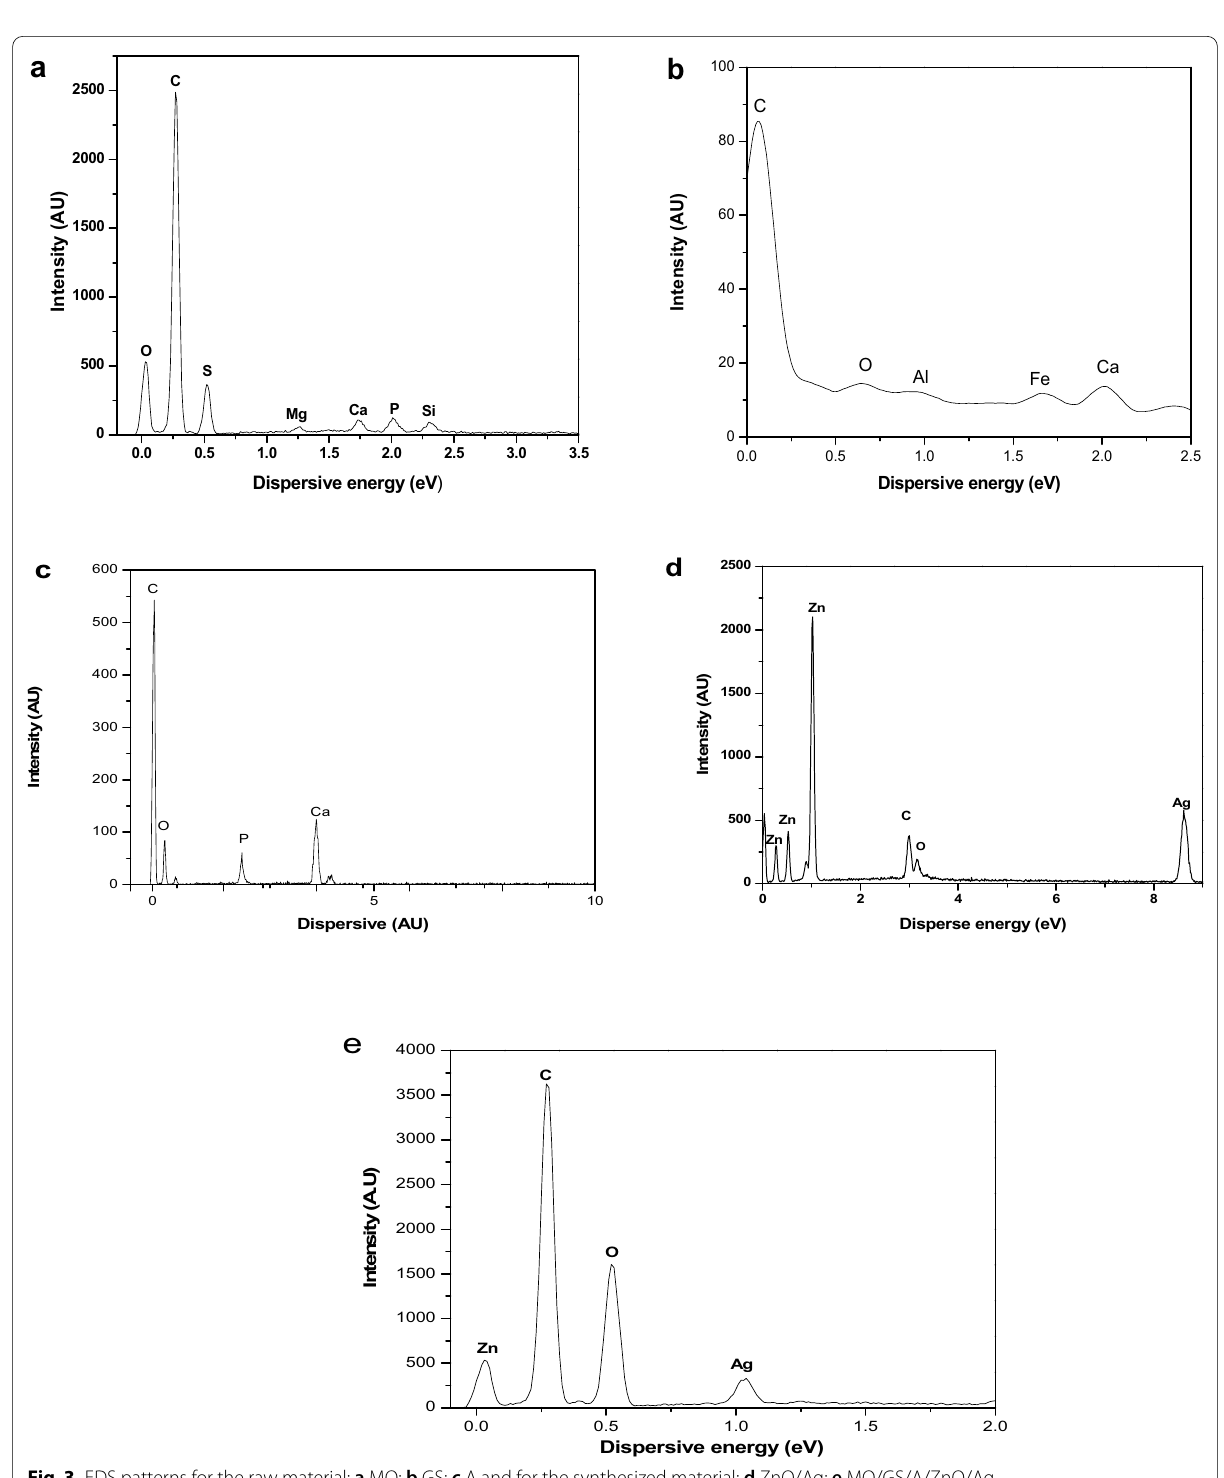
Fig. 3 EDS patterns for the raw material: a MO; b GS; c A and for the synthesized material; d ZnO/Ag; e